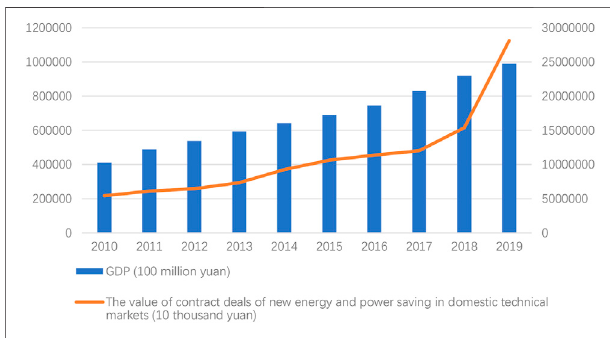
FIGURE 5 | China ’ s GDP and the value of contract deals of new energy and power saving in domestic technical markets (2010 – 2019). Data Sources: China Statistical Yearbook 2011 –